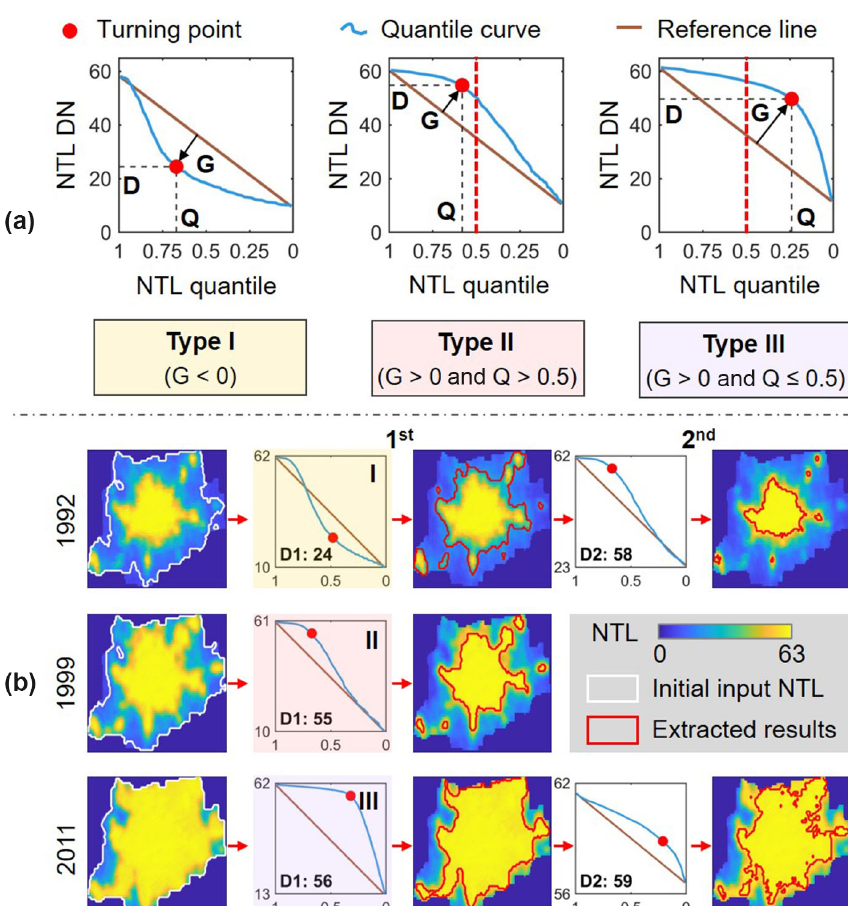
Figure 4. Illustration of the quantile-based strategy. (a) The schematic diagram for identifying three types of urban cluster with the non- gradual pattern. (b) Corresponding examples of urban delineation in different urban cluster categories using the quantile-based strategy. The urban clusters in Beijing in 1992 (type I), 1999 (type II), and 2011 (type III) are selected for